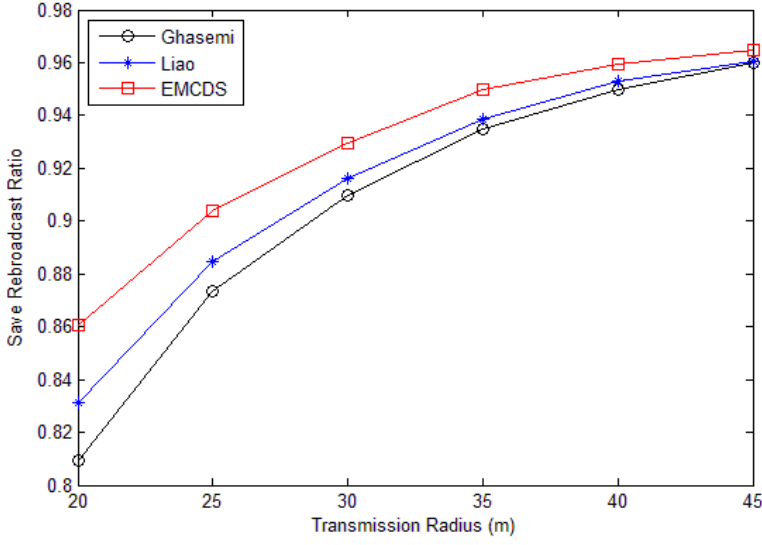
Figure 9. Saved rebroadcast with different transmission range.